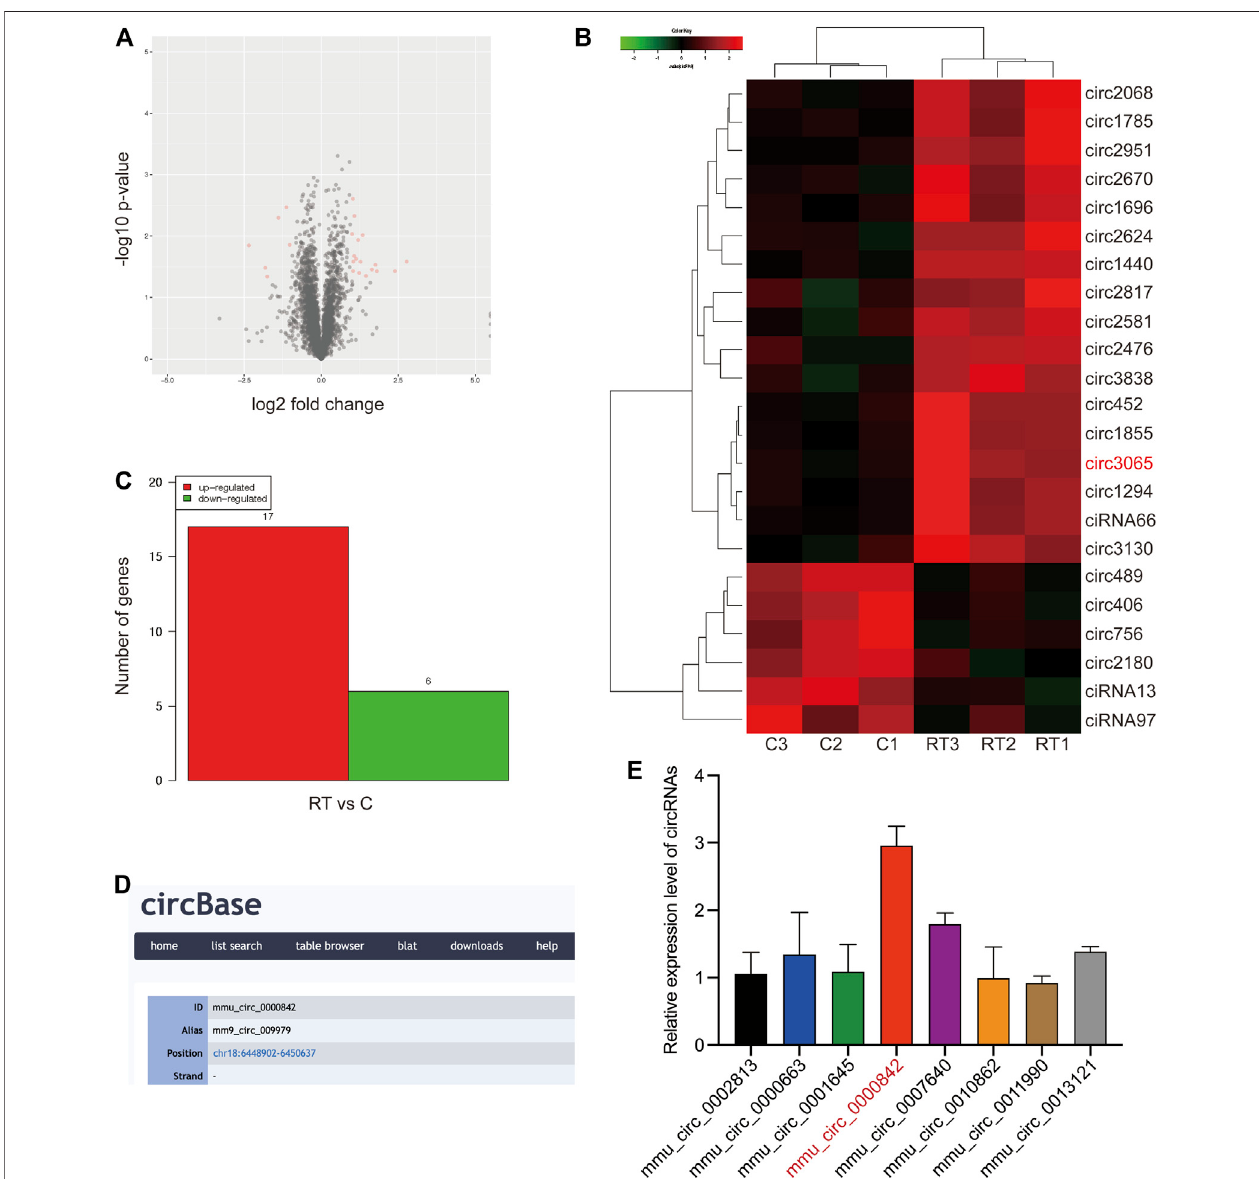
FIGURE 1 | Identi fi cation of circRNAs expression pro fi le. (A) Volcano plots were constructed using fold change values and p-values. The red dot in the plot representsthesigni fi cantlydifferentexpression(foldchange ≥ 2,p < 0.05)ofcircRNAs showingstatisticalsigni fi cance. (B,C) HierarchicalclusteringanalysisofcircRNAs thataresigni fi cantlydifferentiallyexpressedincontrolandRT-treatedRAW264.7cells,including17upregulatedandsixdownregulatedcircRNAs;eachgroupcontained three biological repeats (fold change ≥ 2,p < 0.05).The expression levels are presented indifferentcolorsindicatingexpression levels above and belowthe median expression level across all samples. (D) ID number and alias of mmu_circ_0,000,842 from the circbase database. (E) Expression levels of top8 signi fi cantly differentially expressed circRNAs were determined by qRT-PCR.